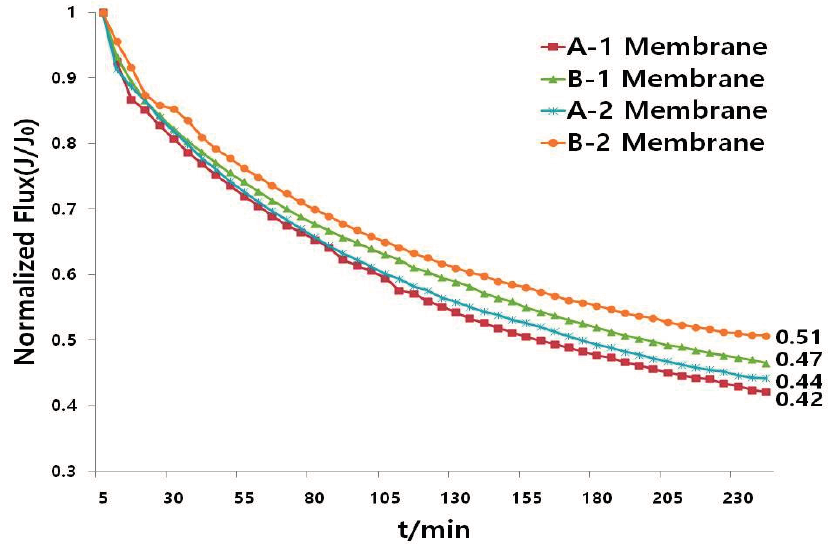
Figure 10. Normalized flux of membranes during filtration of 6 ppm HA solution at 1 bar.